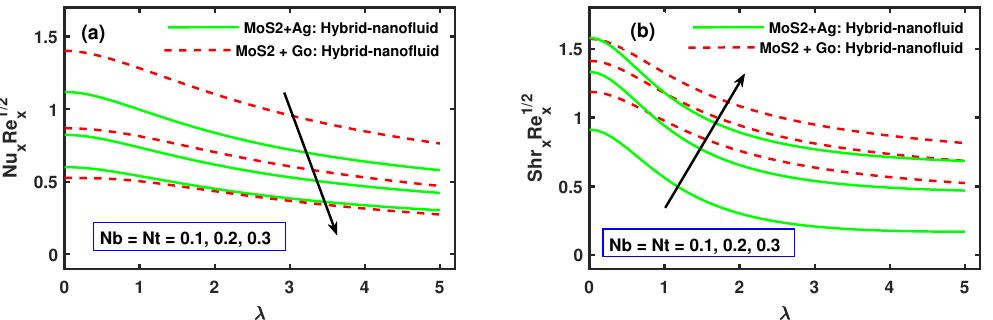
Figure 13. Fluctuation of Nu x Re 1/2 x and Sh x Re 1/2 x along with Nb, Nt (thermophoresis), and λ (rotating parameter).